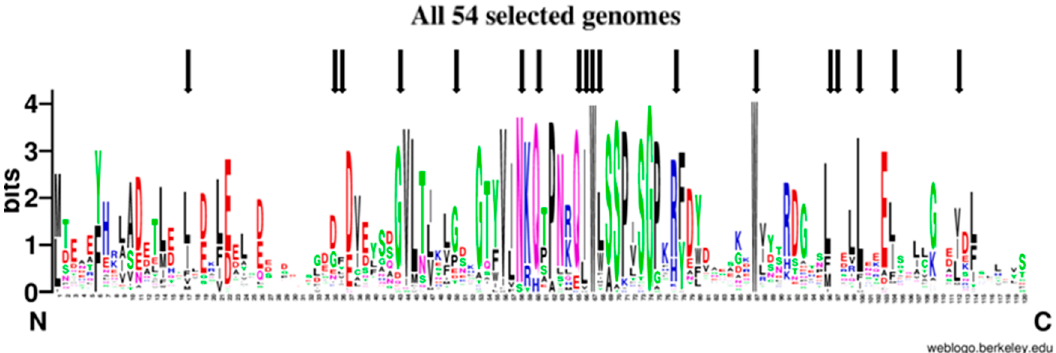
Figure 9. Sequence Logo Visualization of the FXN Functional Domain Alignment Across 54 Representative Genomes. FXN homologues from 54 representative genomes (Tables S1 and S2, Figure S5) were aligned (see materials and methods); black arrows mark positions corresponding to amino acids mutated in FRDA.